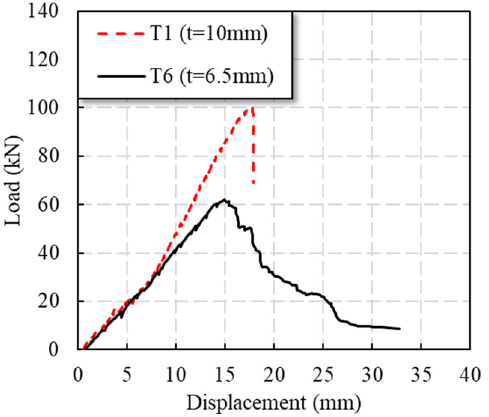
Figure 9. Load–displacement curves of specimens with different plate thicknesses.